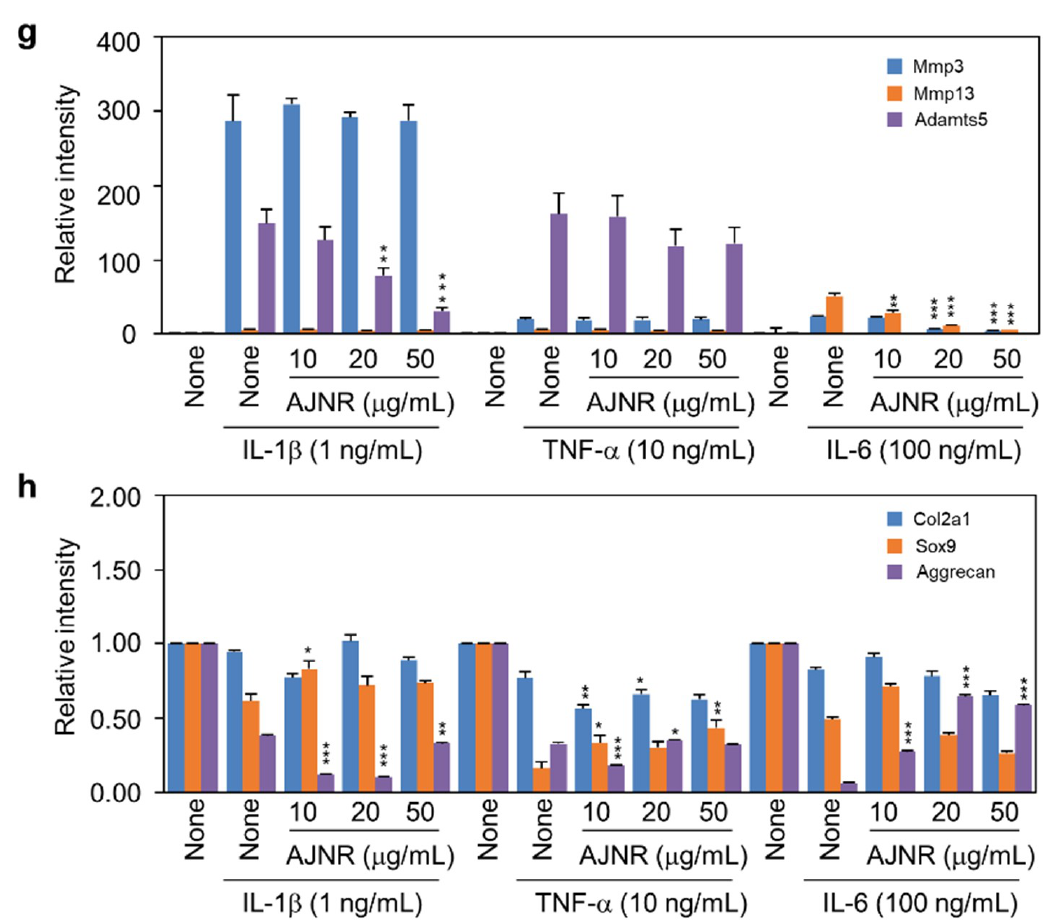
Figure 3. Inhibitory effects of AJNR on pro-inflammatory cytokine-induced catabolic expression in primary cultured chondrocytes. ( a – c ) Anabolic or catabolic factors in primary cultured mouse chondrocytes were analyzed following treatment with IL-1 β , TNF- α , and IL-6. Chondrocytes were pre-incubated with the indicated concentrations of AJNR for 1 h and then stimulated with IL-1 β ( d ), TNF- α ( e ), and IL-6 ( f ) for 24 h. RT-PCR analysis revealed the levels of anabolic and catabolic factors; semi-quantification data are presented in ( g , h ). The results are representative of three independent experiments from different pups. Values are presented as mean ± standard error of the mean (SEM) (* p < 0.05, ** p < 0.01, and *** p < 0.001), as analyzed via one-way ANOVA. Gapdh was used as an internal marker. AJNR, Achyranthes japonica Nakai Root; IL-1 β , interleukin-1 β ; IL-6, interleukin 6; TNF- α , tumor necrosis factor- α ; Epas1, endothelial PAS